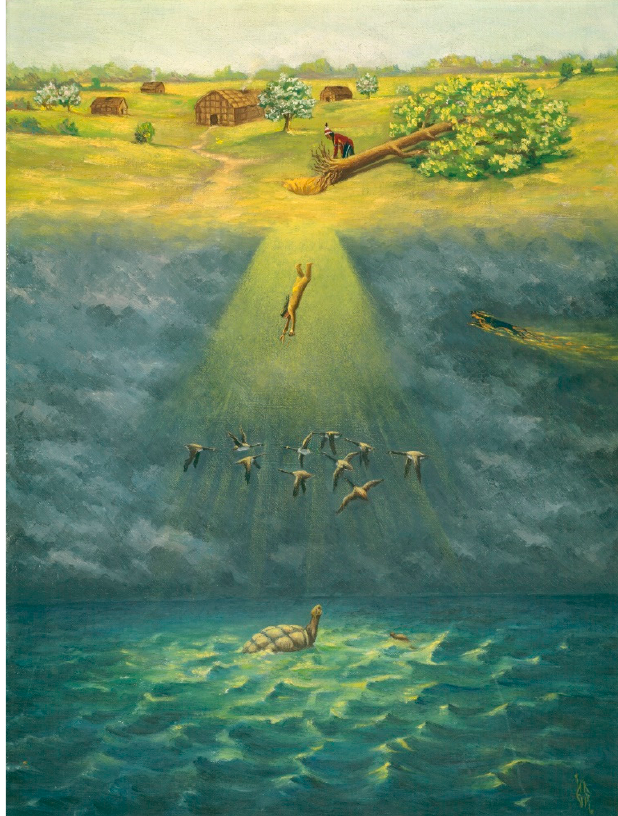
Figure 8. Ernest Smith, Sky Woman , 1936. Oil on board, with permission of the Rochester Museum and Science Center.